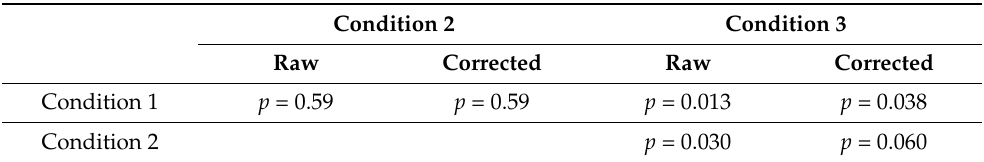
Table 3. Tukey tests: comparison of combined effects of walking conditions on trunk vertical